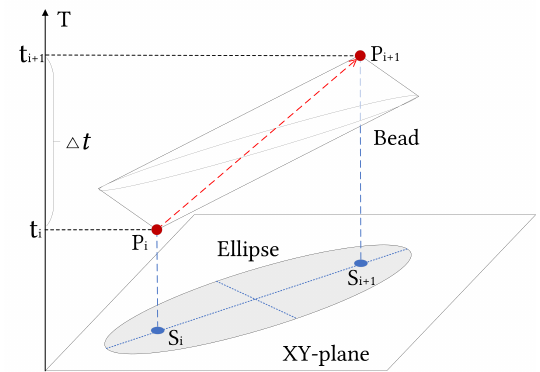
Figure 2. ST-bead and